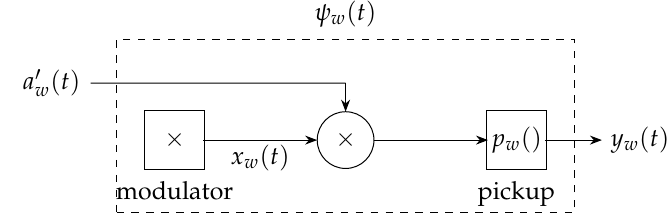
Figure 6. One tonewheel processor in the